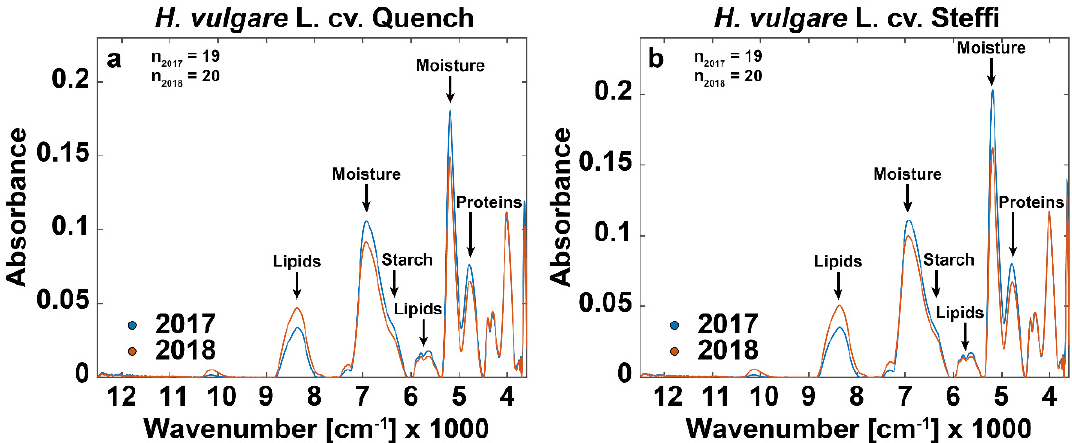
Figure 4. Comparison of spring barley kernel FT-NIR spectra. Figures display baseline-corrected average FT-NIR spectra (4000 to 12,000 cm − 1 ) for whole kernels of the spring barley varieties ( a ) Quench and ( b ) Steffi. Samples are grouped based on the crop years 2017 (blue) and 2018 (red). Assignments of relevant spectral bands are indicated at the respective absorbance peak.